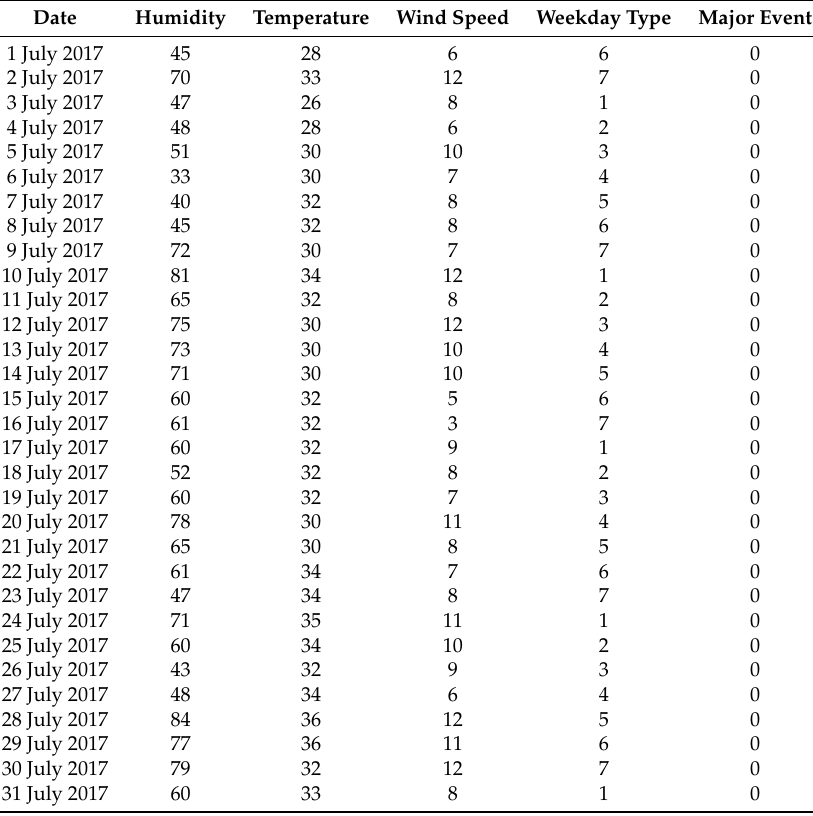
Table A1. Basic information in July